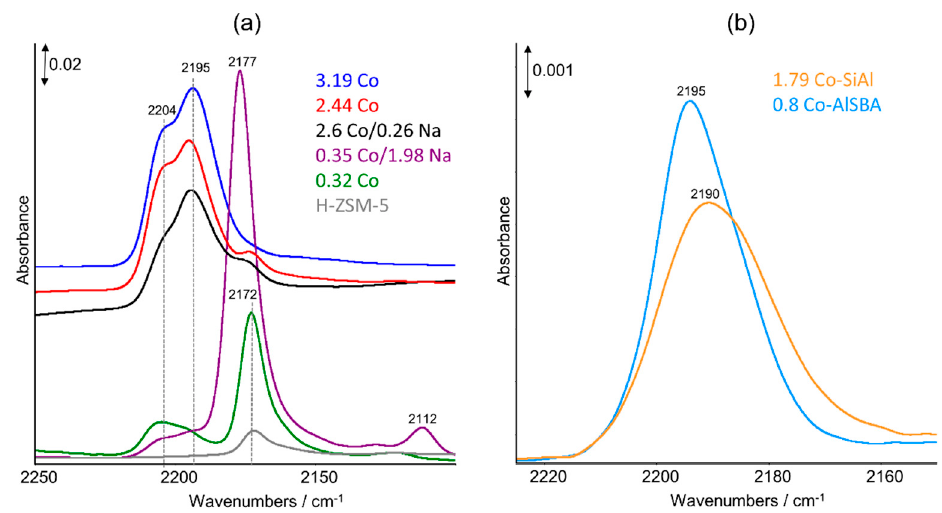
Figure 3. CO adsorbate spectra of Co-ZSM-5 samples ( a ) and 1.79 Co-SiAl as well as 0.8 Co-AlSBA ( b ) measured at − 60 °C.